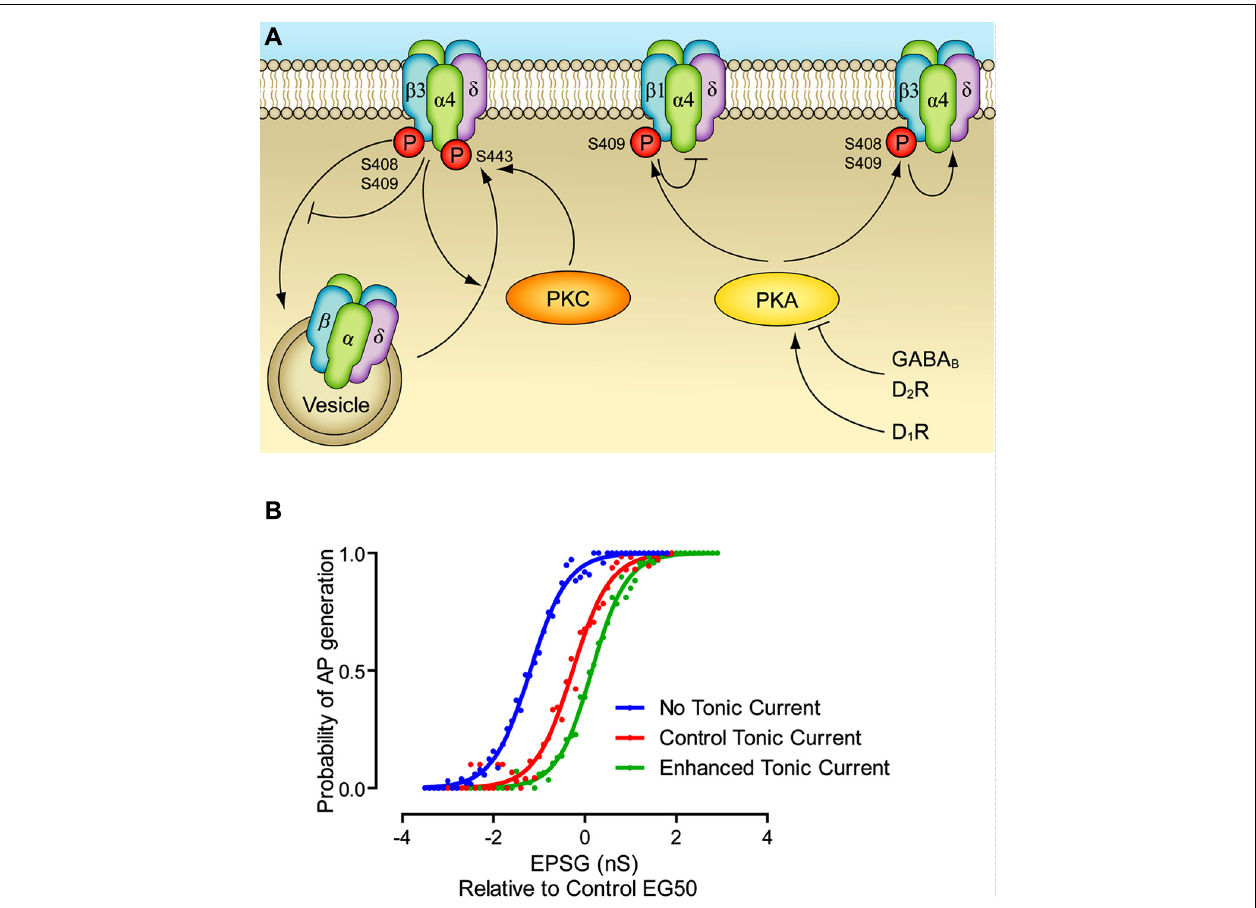
of the tonic current on the neuronal input/output (I/O) function. Dynamic clamp was used to inject excitatory postsynaptic conductances (EPSGs) into neurons in control conditions, when the tonic GABA A current was blocked by gabazine, and when the tonic current was enhanced to the level produced by GABA B receptor agonists.There was no artificial injection of excitatory noise in this experiment, though the tonic current was produced via a noisy conductance model. Note that altering the level of the tonic current changes the offset of I/O function, without affecting the gain. Modified from Connelly etal.